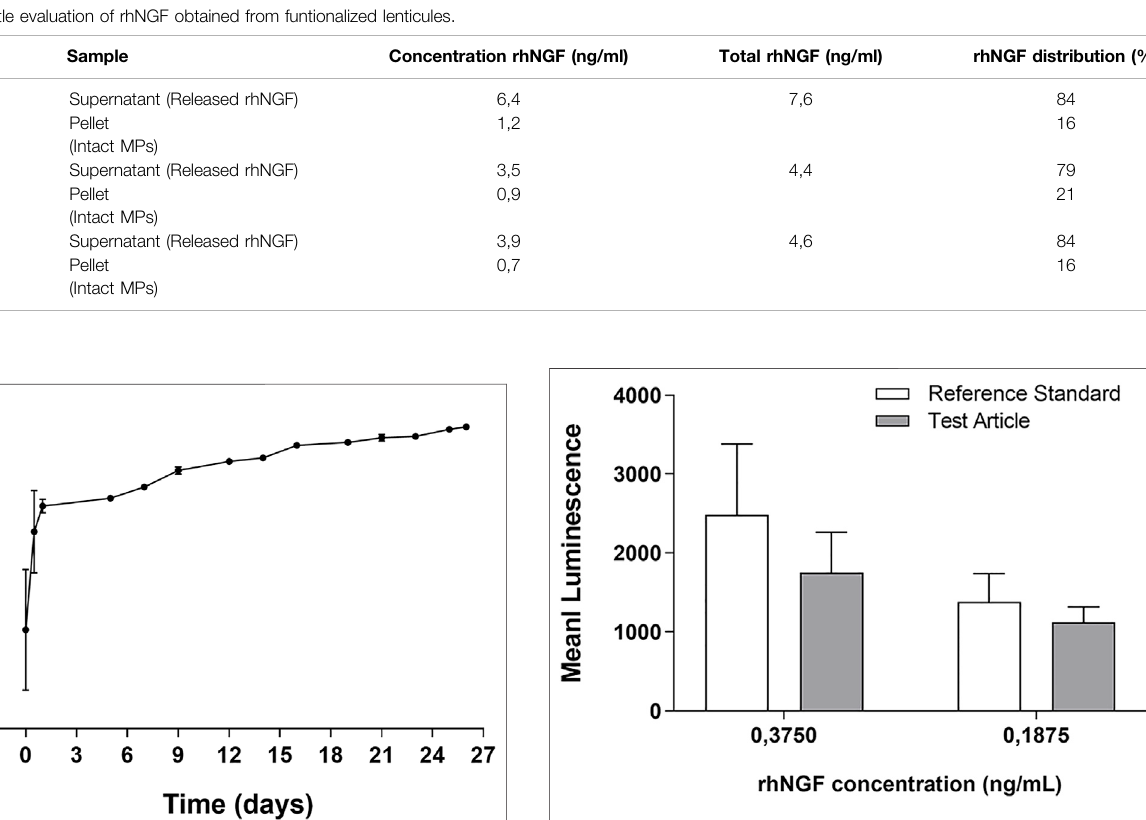
FIGURE 7 | rhNGF activity test using PC12-Luci cell line. The graph shows the luminescence emission of active rhNGF released from the engineered lenticules (Test Article, grey bar) compared with rhNGF reference standard (white bar). The rhNGF reference standard tested was used at 2 different concentrations (0,3750 and 0,1875 ng/ml). Data are reported as mean ± SD ( n = 3). (Mann-Whitney U test; p > 0.05, not signi fi